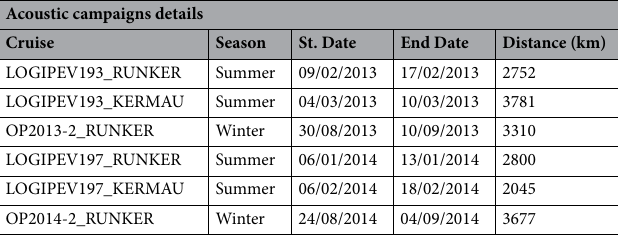
Table 1. Details of the acoustic transects